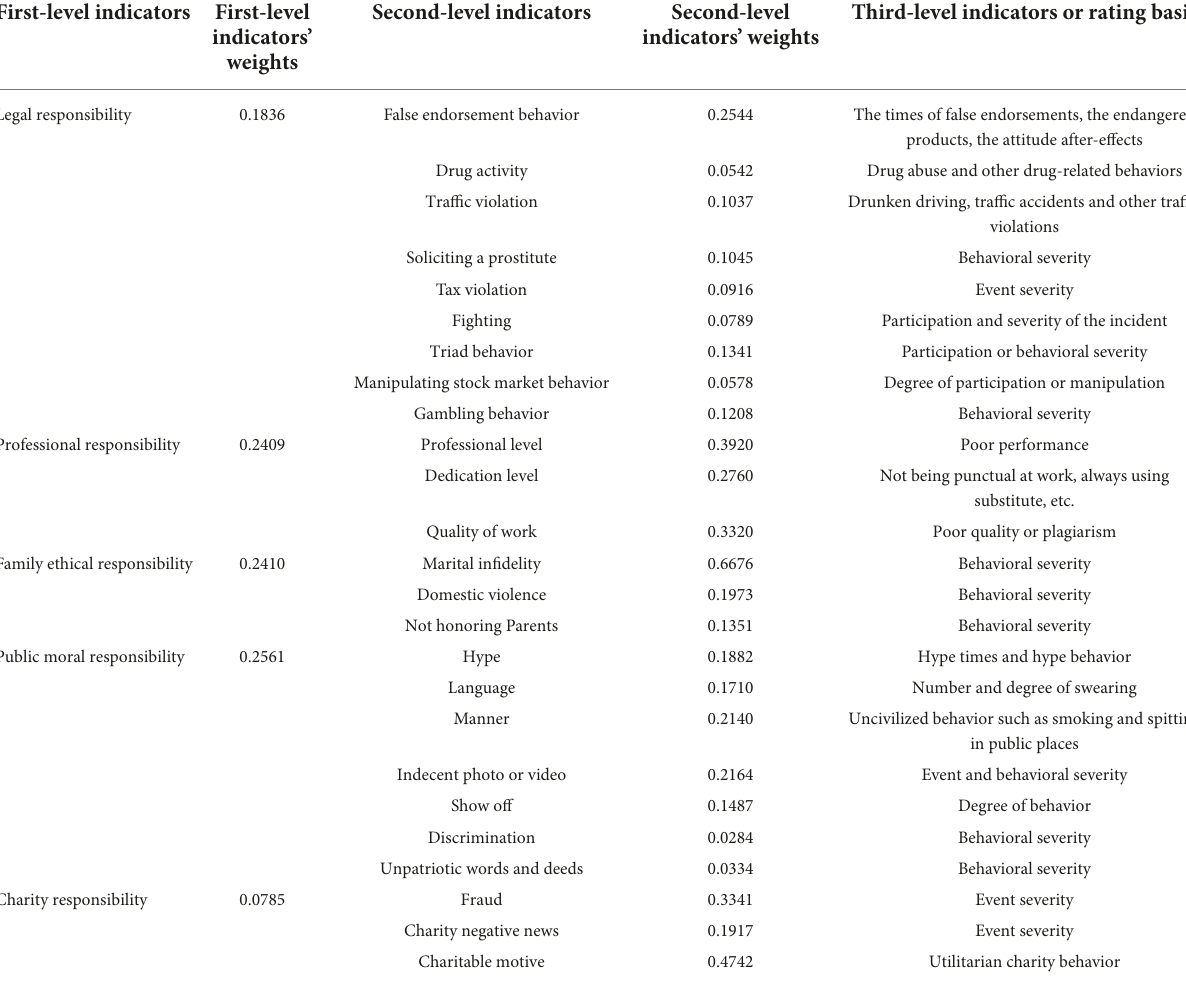
TABLE 1 Cinematic celebrity social responsibility scale and weights.